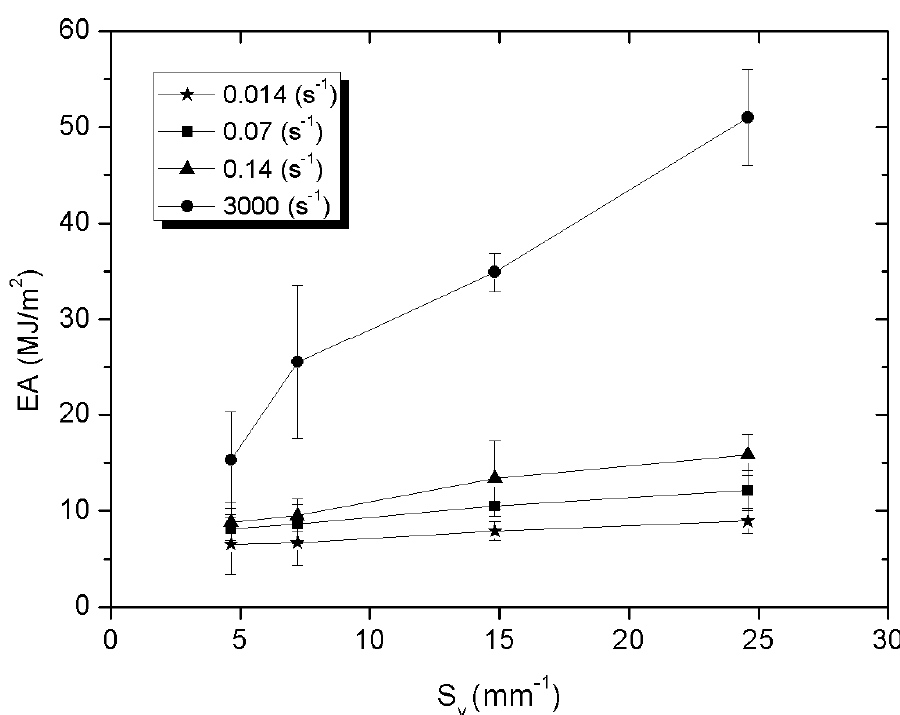
Figure 11. Absorbed energy of ceramic-elastomer composites depending on S v parameter for 1.4 · 10 − 3 , 7 · 10 − 2 , 1.4 · 10 − 1 , and 1 · 10 3 s − 1 strain rate.